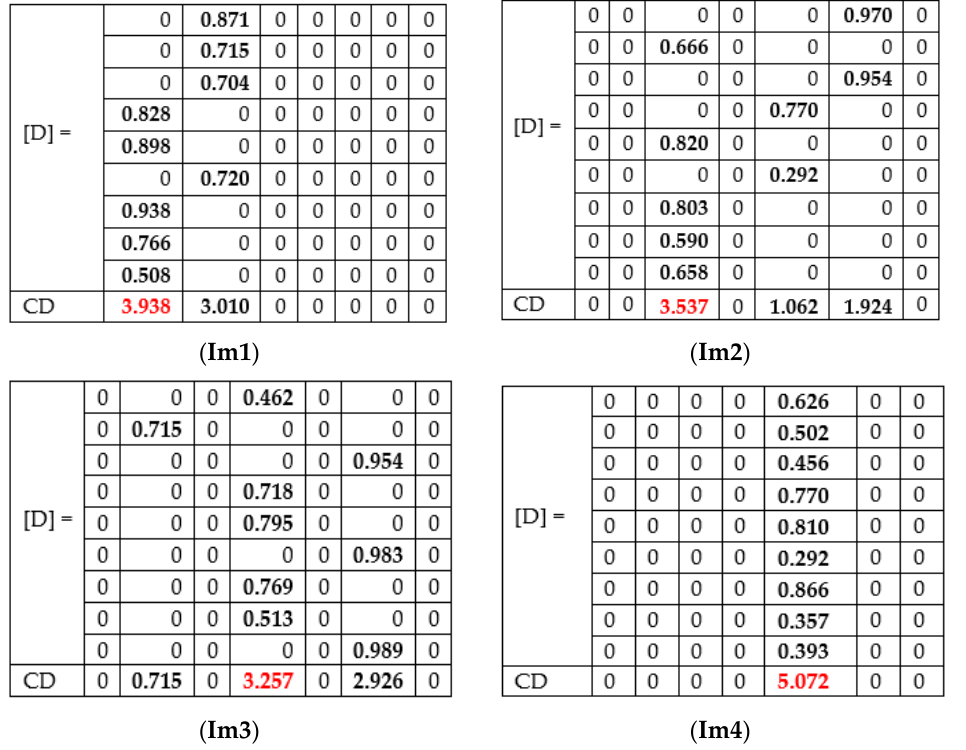
Figure 18. Decision matrices [D] and Collective decision CD for images Im 1, Im 2, Im 3, and Im 4.